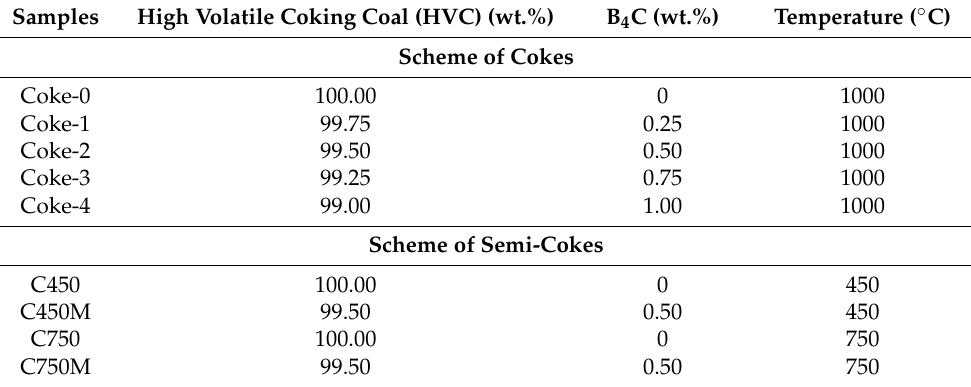
Table 1. Carbonization schemes for coke and semi-coke.